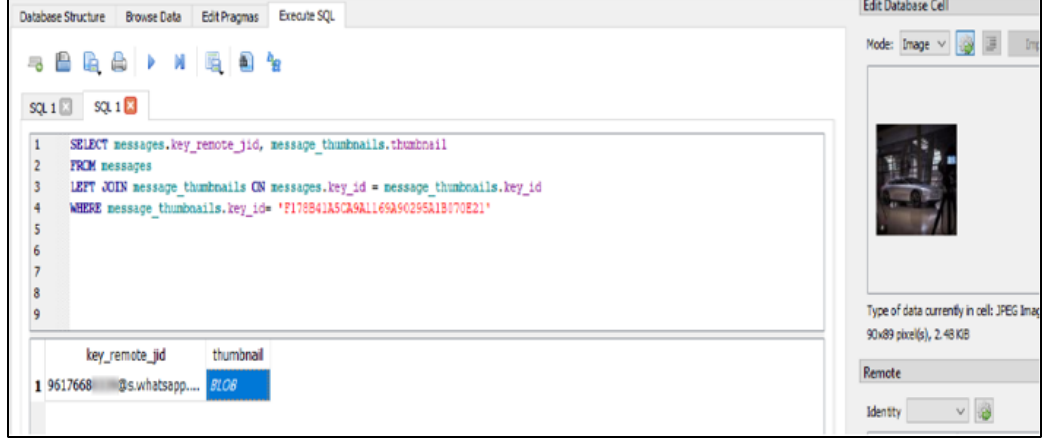
Figure 15. The thumbnail of an image